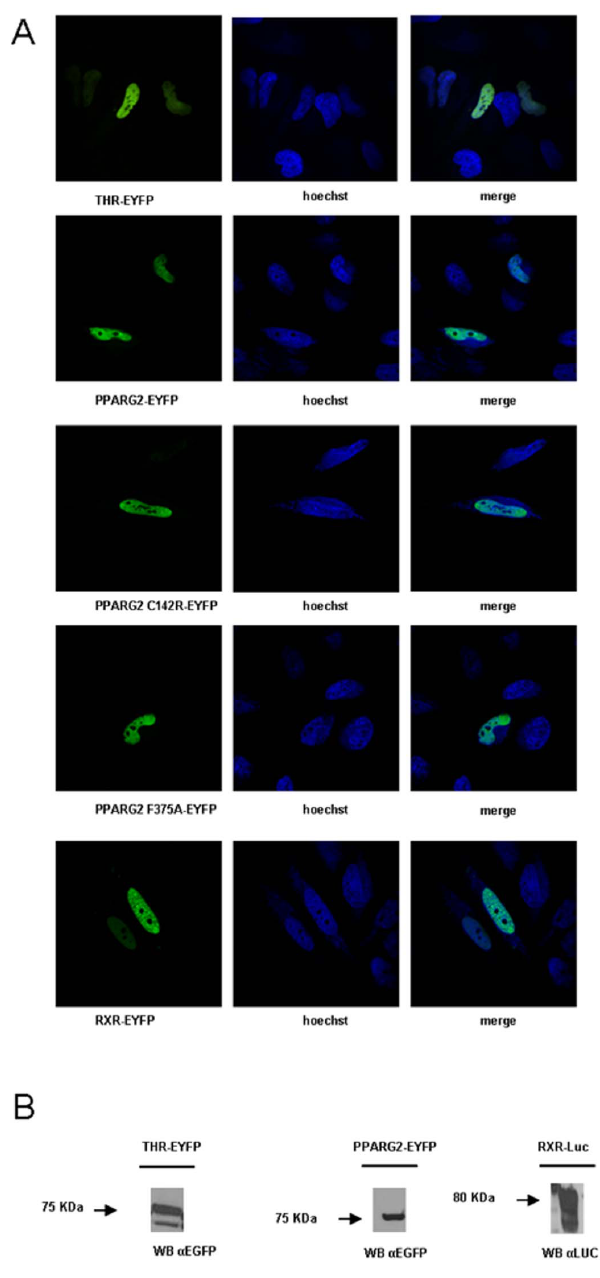
Figure 1. Expression and localization of NR fusion proteins. (A) Localization of THR, RXR and PPARG2 proteins in the nucleus. Hela cells transfected with the respective EYFP fused NR expression vector were stained with Hoechst 33342. Left images show the specific localization of each EYFP fusion protein; middle images show the nuclei revealed by Hoechst staining; right images show merge images between EYFP and DNA staining. (B) Protein identity confirmed by Western blot. HEK293T cells transfected with the respective EYFP or Luc fused NR expression vectors were lysed in RIPA buffer and analyzed by Western blot. Anti- GFP antibodies were used to detect THR-EYFP and PPARG2-EYFP, and anti-Renilla Luciferase antibody was used to visualize RXR-Luc. doi:10.1371/journal.pone.0084569.g001 A short incubation of cells with agonists 2.10 2 6 M 9cisRA and 10 2 5 M of Troglitazone (TROG) for 5–10 min induced an increase of BRET max between RXR-Luc and PPARG2-EYFP.